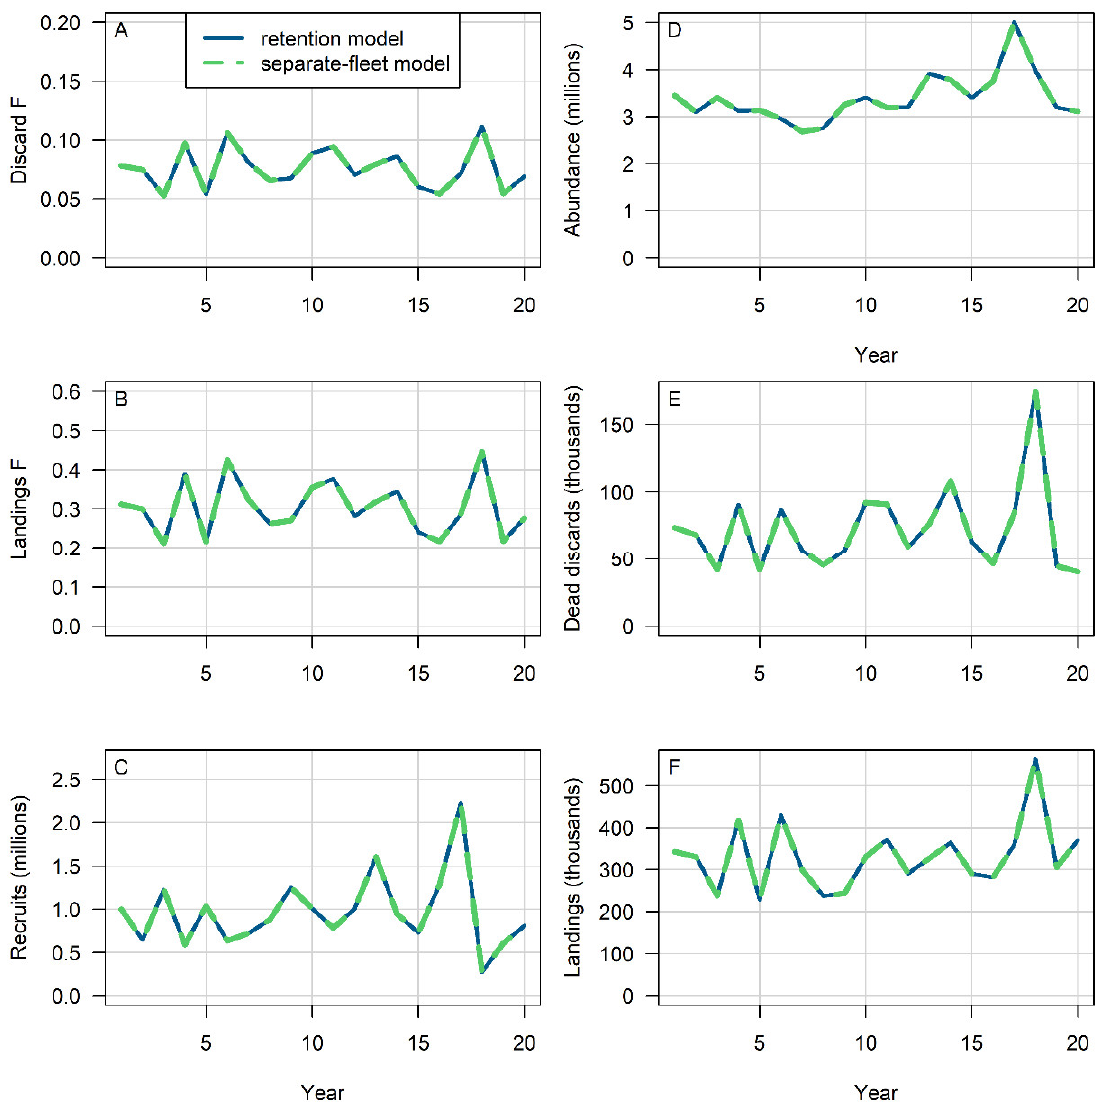
Figure 3. Results of Simulation 1 using the retention model (blue, solid) or separate-fleet model (green, dashed). ( A ) Fishing rate (y −1 ) toward discard mortality. ( B ) Fishing rate (y −1 ) toward landings. ( C ) Recruitment. ( D ) Abundance. ( E ) Dead discards. ( F ) Landings. Note that blue and green curves overlap in each panel.